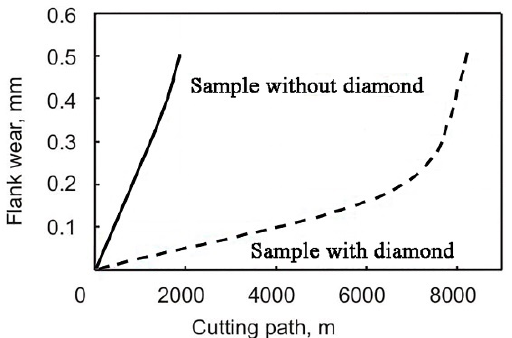
Figure 10. Period of service of the tool with and without diamond coating under the turning of the A-390 type metal-matrix composite with 18% SiC